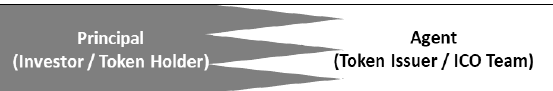
Figure 2: Principal and Agent in the context of cryptocurrencies & interwoven